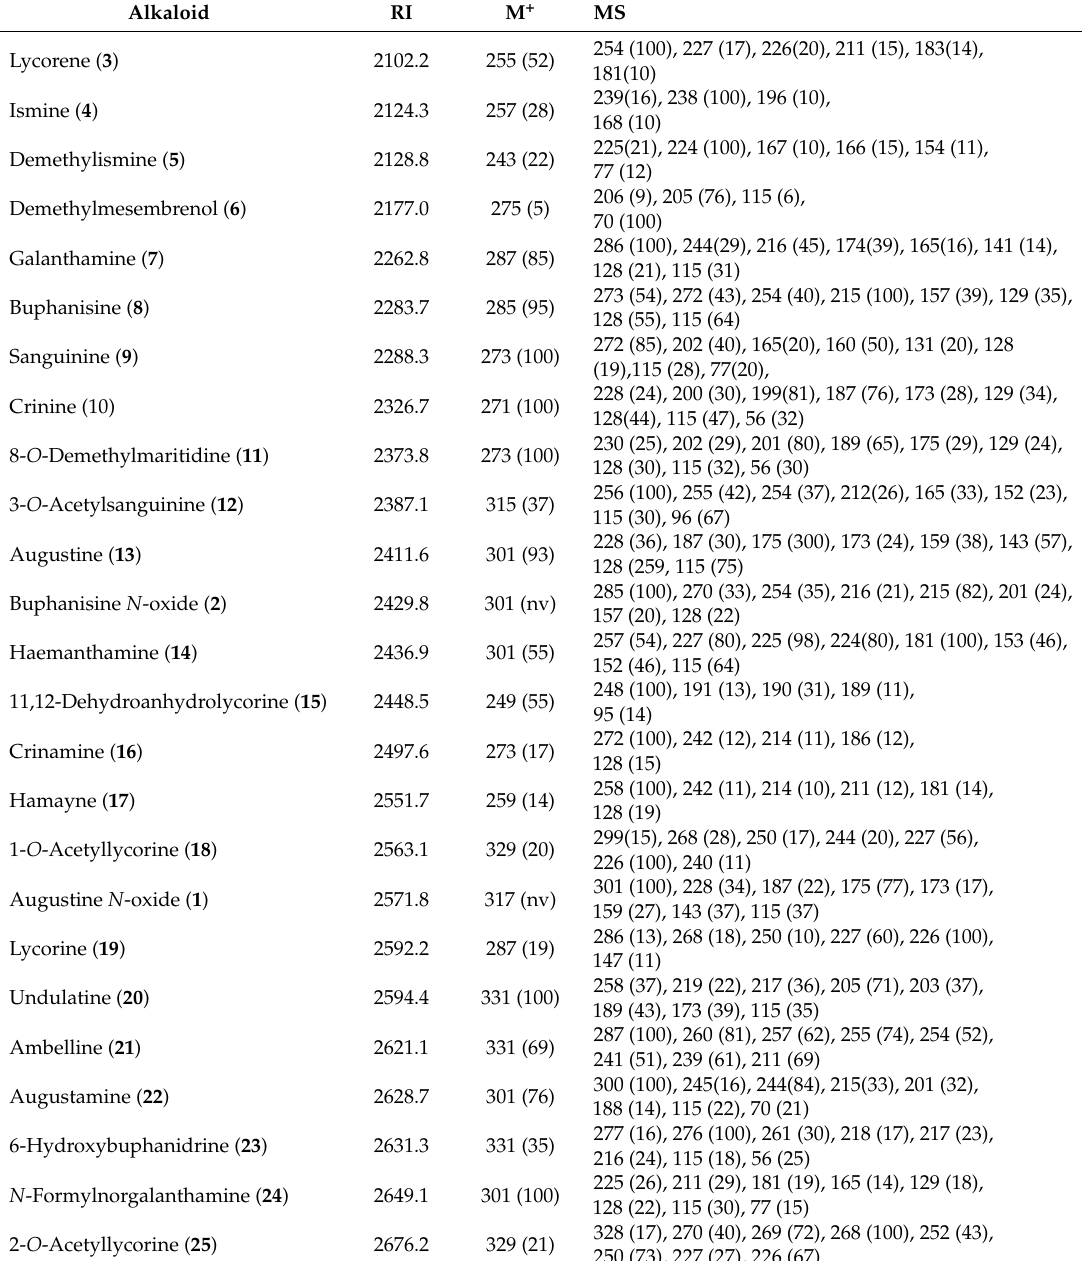
Table 1. Alkaloids identified in Crinum amabile by